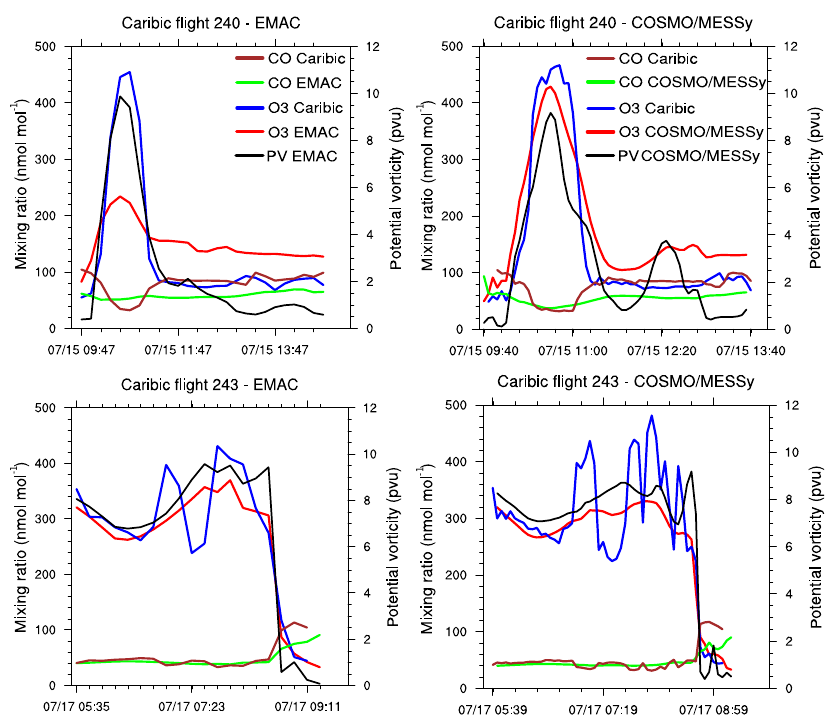
Figure 15. Comparison between IAGOS-CARIBIC measurements of ozone, carbon monoxide (left axis in nmolmol − 1 ) for EMAC (left side) and CM50 (right side). The upper row shows the results for the IAGOS-CARIBIC flight 240 and the lower row for the flight 243. For both models, also the potential vorticity (right axis in PVU) is displayed as a proxy for tropospheric or stratospheric air